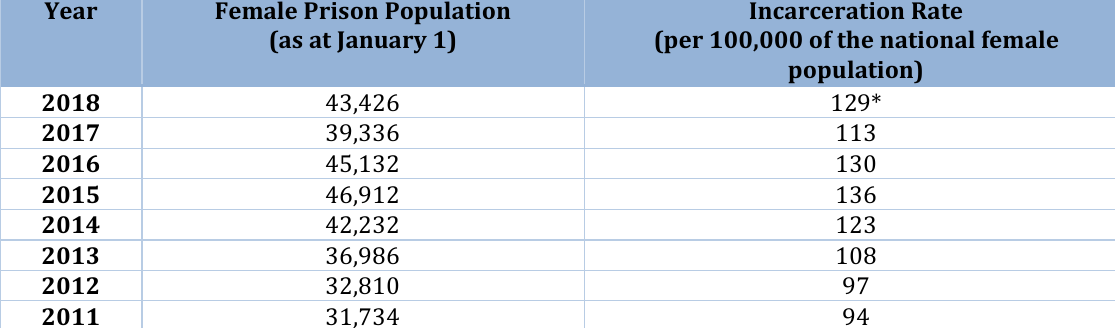
Table 1: Rate of incarceration of women in Thailand (2011 – 2018) Year Female Prison Population Incarceration Rate (as at January 1) (per 100,000 of the national female population) 2018 43,426